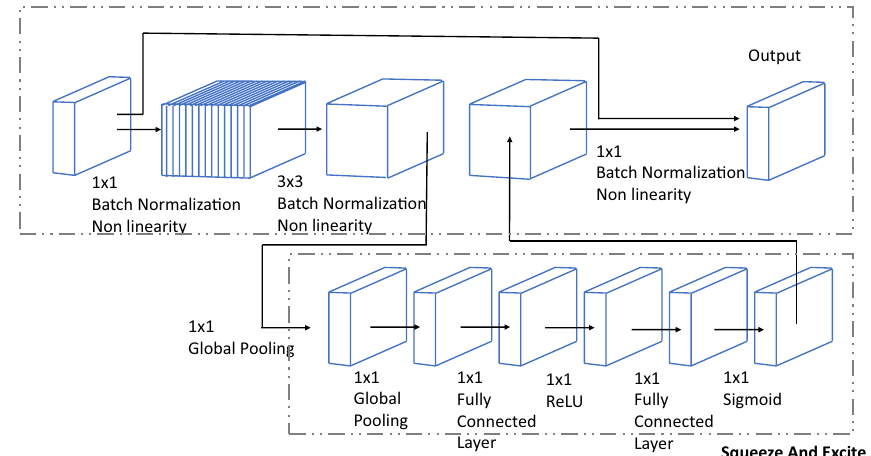
Figure 4. DeepLabv3+ semantic segmentation architecture.